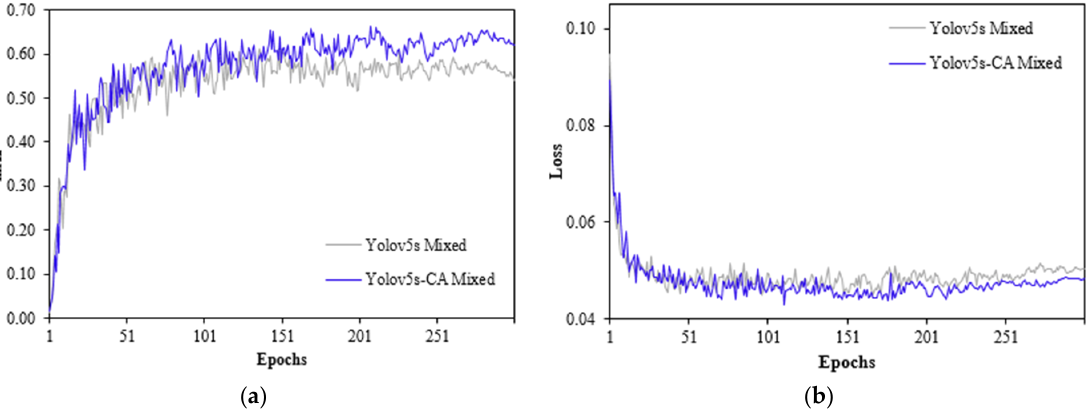
Figure A2. Experimental results of each model on the synthetic dataset. ( a ) mAP @0 . 5 curves for the synthetic dataset. ( b ) Loss curves for the synthetic dataset.